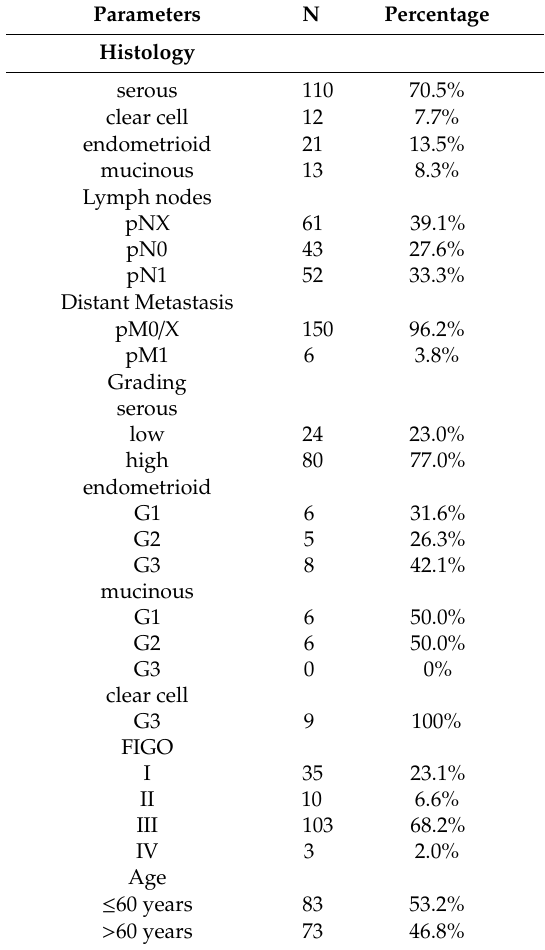
Table 4. Patient